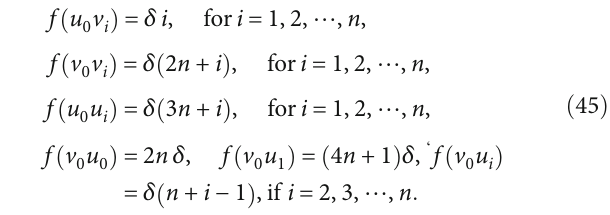
Figure 19: The butter fl y graph B